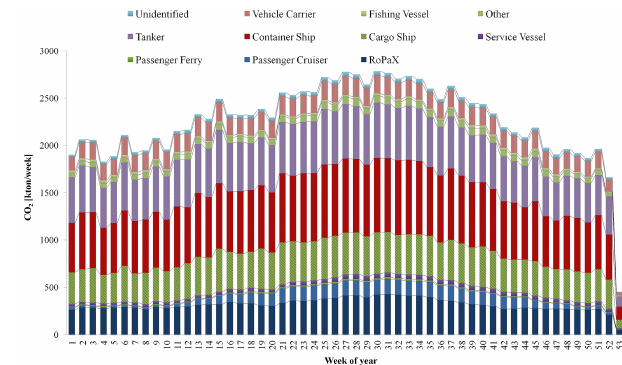
Figure 7. Seasonal variation of the shipping emissions of CO 2 in the European sea regions in 2011, classified in terms of various ves- sel